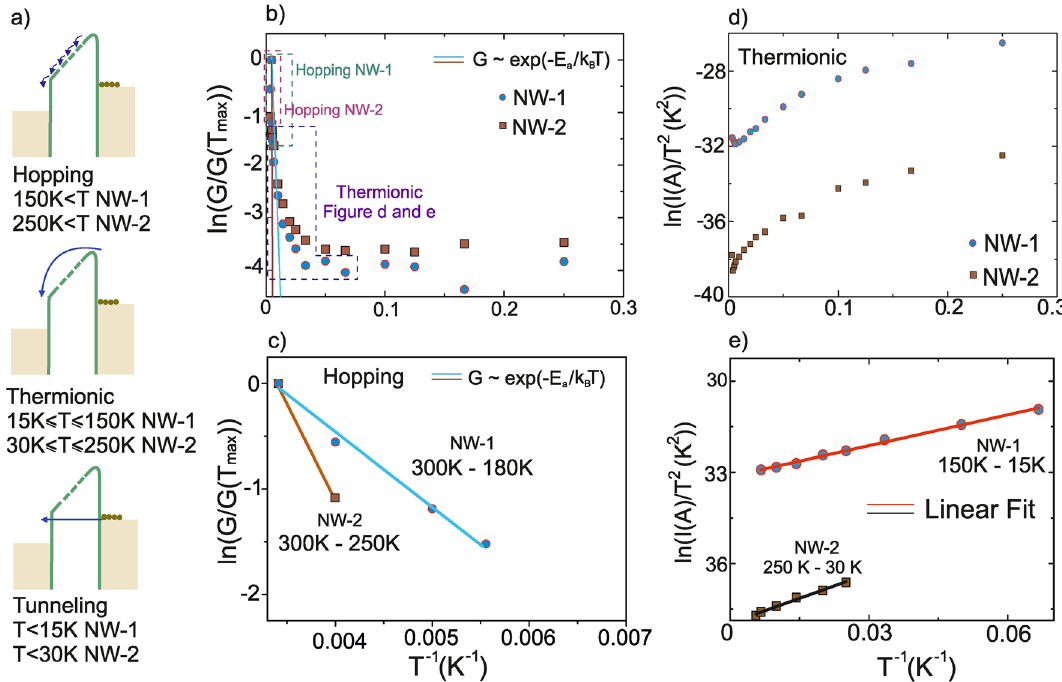
Figure 5. ( a ) Representative diagram of hopping, thermionic and tunneling injection processes over the barrier between metallic contacts and nanoparticles. ( b ) Inverse temperature dependence of conductance for NW-1 and NW-2. ( c ) Linear fit of data shown in ( b ) in the high-temperature range, in which hopping is the dominant 2 charge transport mechanism. ( d ) Plot of ln ( I )/ T according to the Richardson-Schottky model describing thermionic emission. ( e ) Linear fit of the data shown in d) in the intermediate temperature range, in which thermionic emission dominates charge